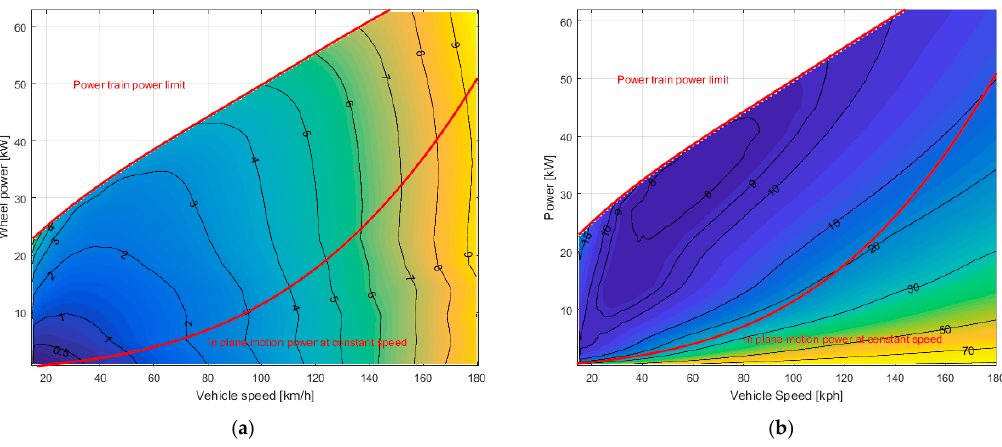
Figure 12. ( a ) Electrical losses (kW) as a function of wheel power and vehicle speed; and ( b ) electrical losses (%) in percentage with respect to ICE power, as a function of wheel power and vehicle speed.